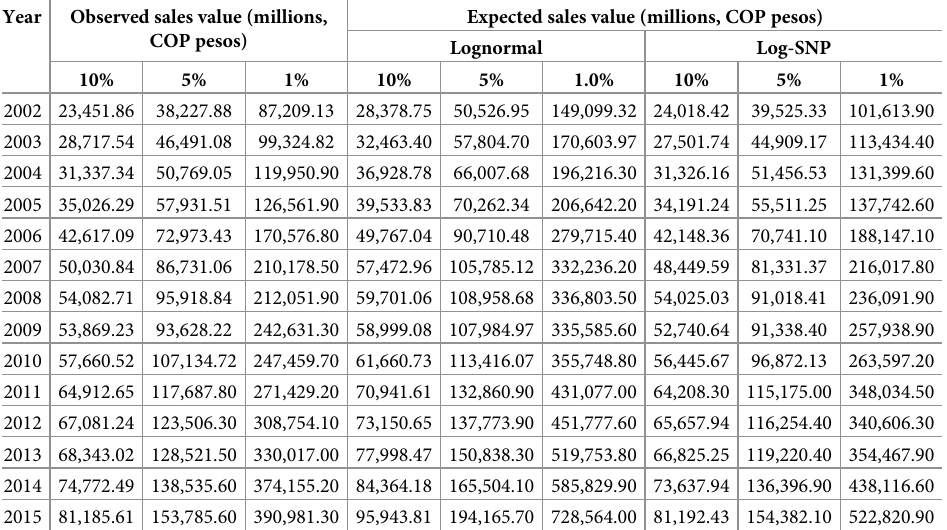
Table 3. Sales obtained empirically versus values expected theoretically using a lognormal distribution and log- semi-nonparametric distribution. Year Observed sales value (millions, COP